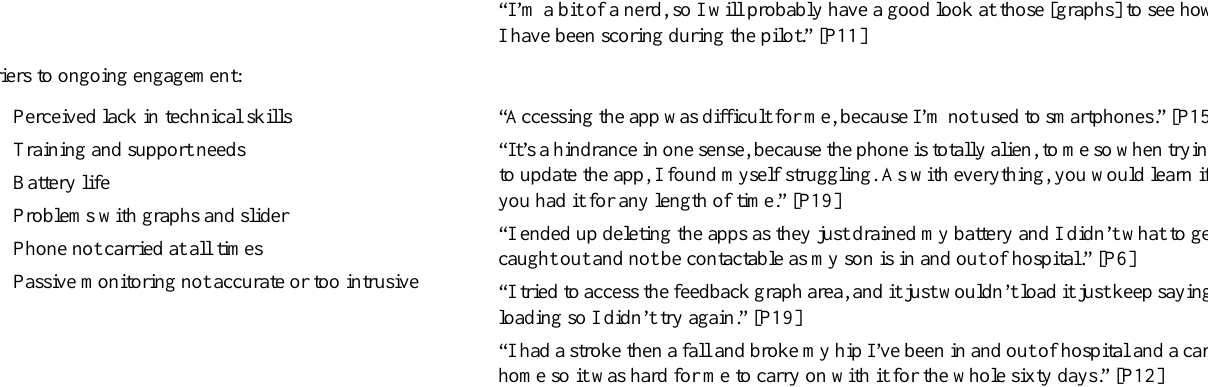
Example extractsThemes and summary of main